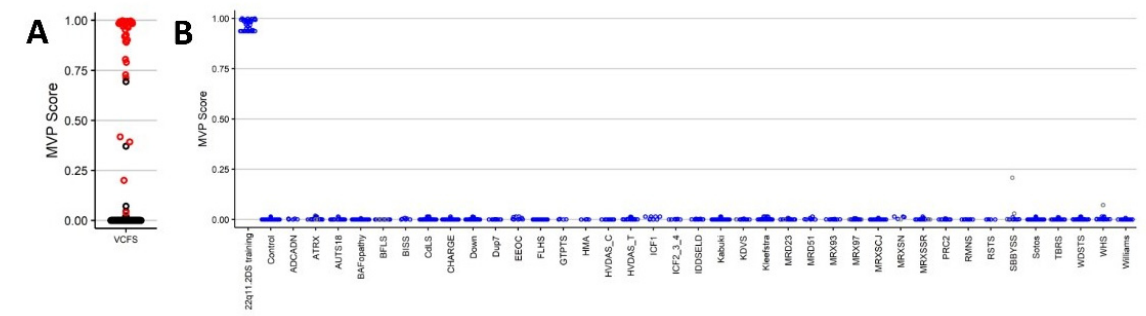
Figure 3. ( A ) Leave-1-out cross validation. Each sample was used for testing once and plotted with the remaining 31 samples used for training. Figure depicts a summary of the MVP classifier used during cross validation. Each 22q11.2DS testing sample is marked in red; all other samples in the classifier are depicted in black. ( B ) SVM classifier model. Model trained using the selected probes from the 22q11.2DS training cases, 75% of controls and 75% of other neurodevelopmental disorder samples (depicted in blue). The remaining 25% of controls and 25% of other disorder samples were used for testing (displayed in grey). Plot shows the 22q11.2DS cases with an MVP score close to 1 compared with all other samples, showing the specificity of the classifier to detect 22q11.2DS samples.